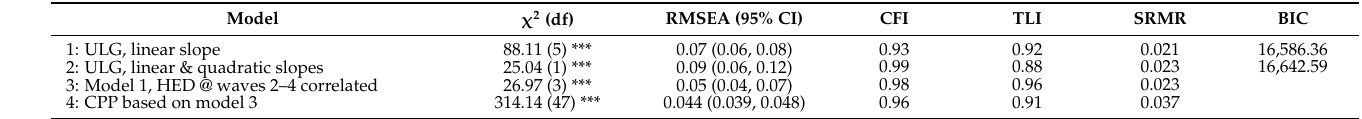
Table 4. Goodness-of-fit statistics for structural equation models of the relationship between depres- sive symptoms and